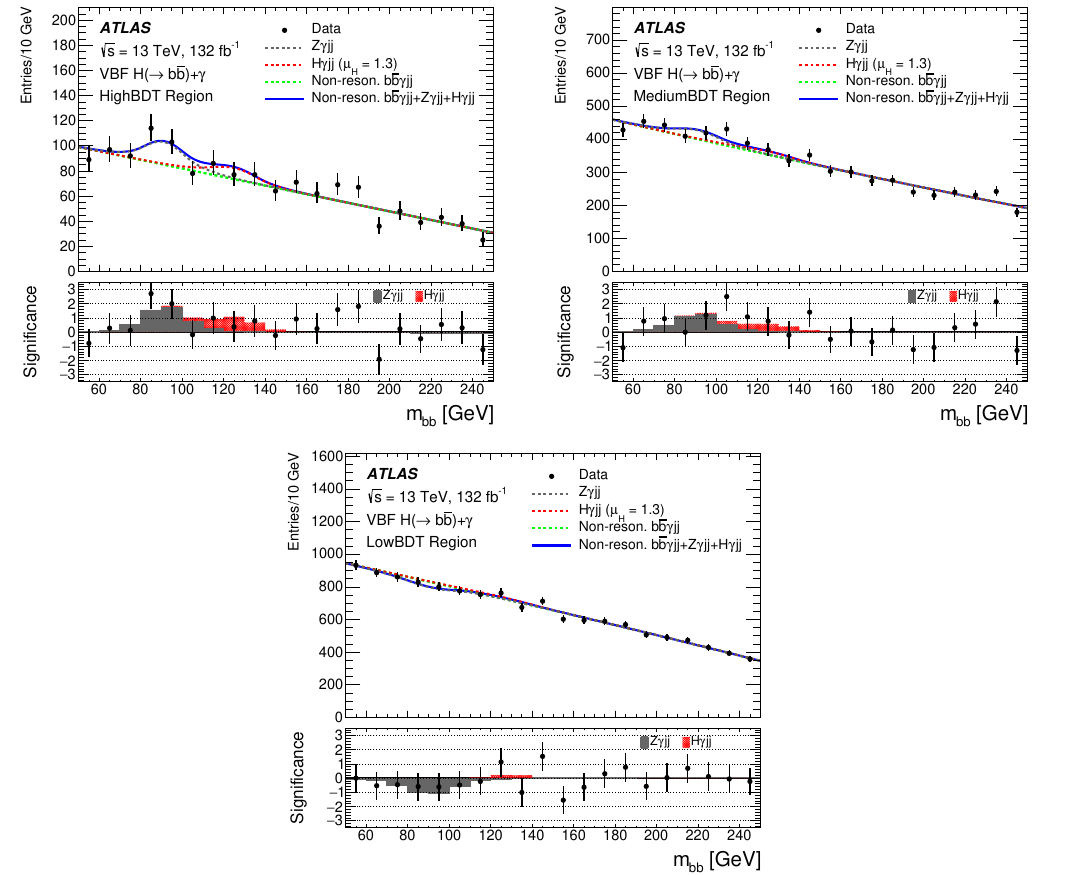
Figure 5 . The m bb distributions in the three event categories, overlaid with contributions from the H(cid:13)jj signal as well as the resonant Z(cid:13)jj and non-resonant b (cid:22) b(cid:13)jj background (cid:12)ts. The combined (cid:31) 2 per degree of freedom is 45 : 2 = 45. The bottom panel in each plot presents the signi(cid:12)cance of the Higgs boson signal relative to the non-resonant b (cid:22) b(cid:13)jj background in each bin, calculated using a Poisson model